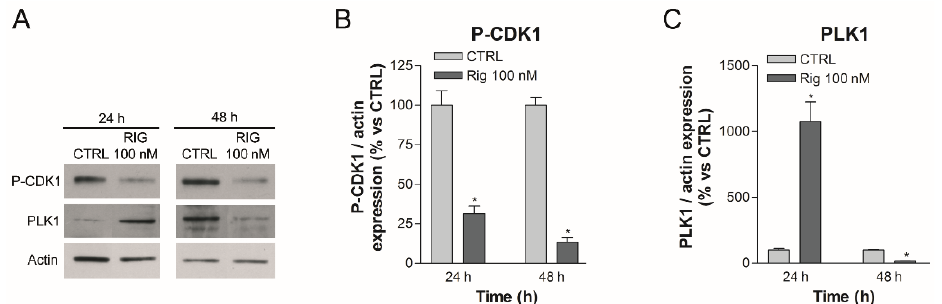
Figure 4. Western blot analysis of P-CDK1 and PLK1 in EGI-1 cells treated with Rig. ( A ) Representative images of P-CDK1, PLK1 and actin after treatment with different concentrations of 100 nM Rig for 24 and 48 h. ( B ) The graph represents the quantification of P-CDK1 Western blot, normalized to actin. ( C ) The graph represents the quantification of PLK1 western blot, normalized to actin. All the graphs are represented as the mean percentage ± SD of at least three independent experiments and are compared to untreated controls arbitrarily set to 100%. * p < 0.05 vs. CTRL.